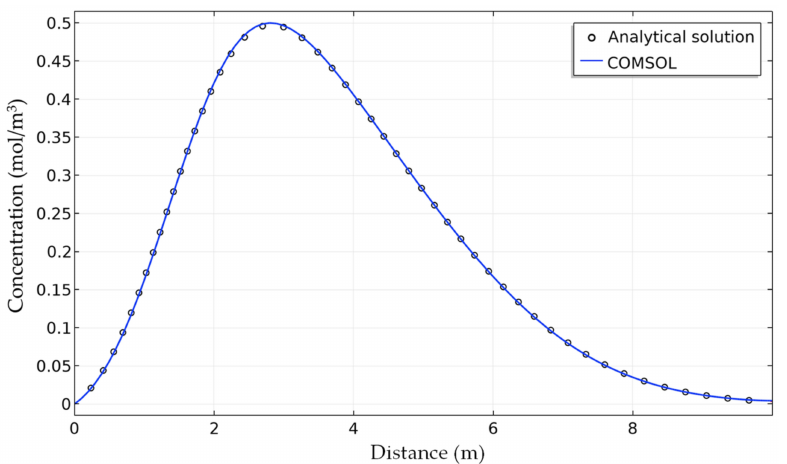
Figure 6. Comparison between COMSOL 1D transport model and analytical solution in the case of the transient decay tracer.